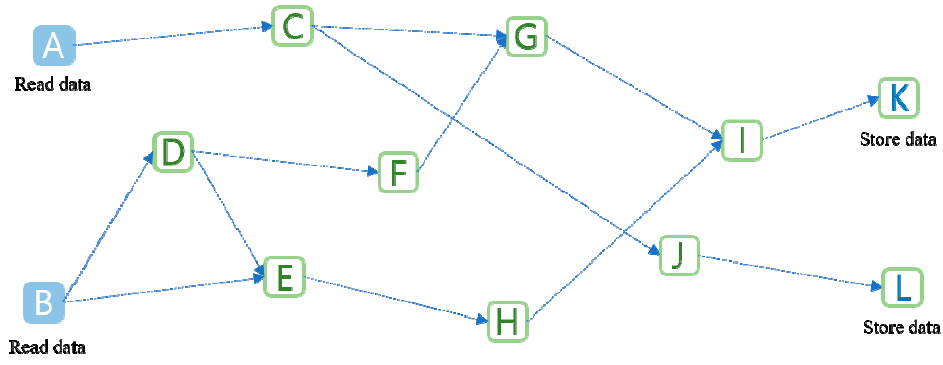
Figure 1. Structure of Directed Acyclic Graph (DAG).